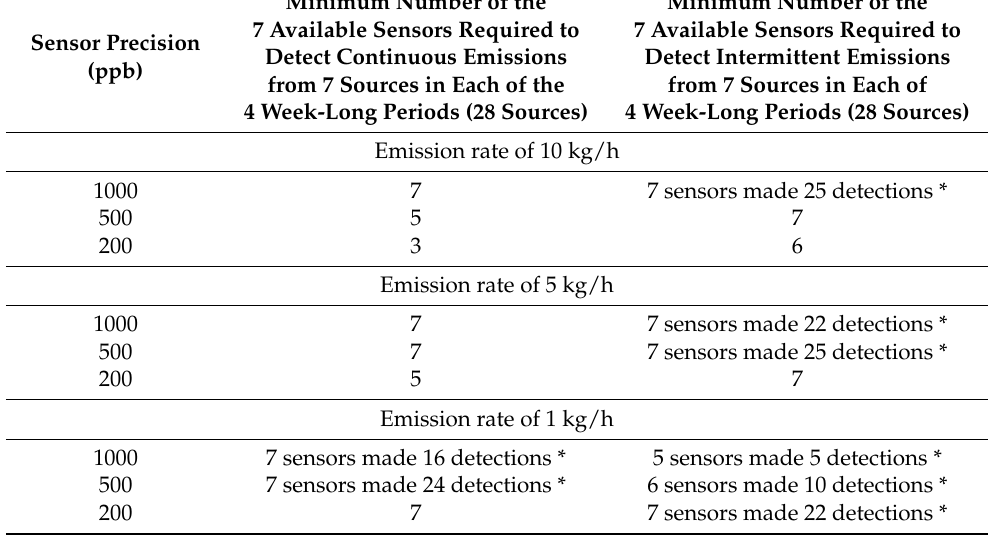
7 sensors made 16 detections * 5 sensors made 5 detections * 200 7 sensors made 22 detections